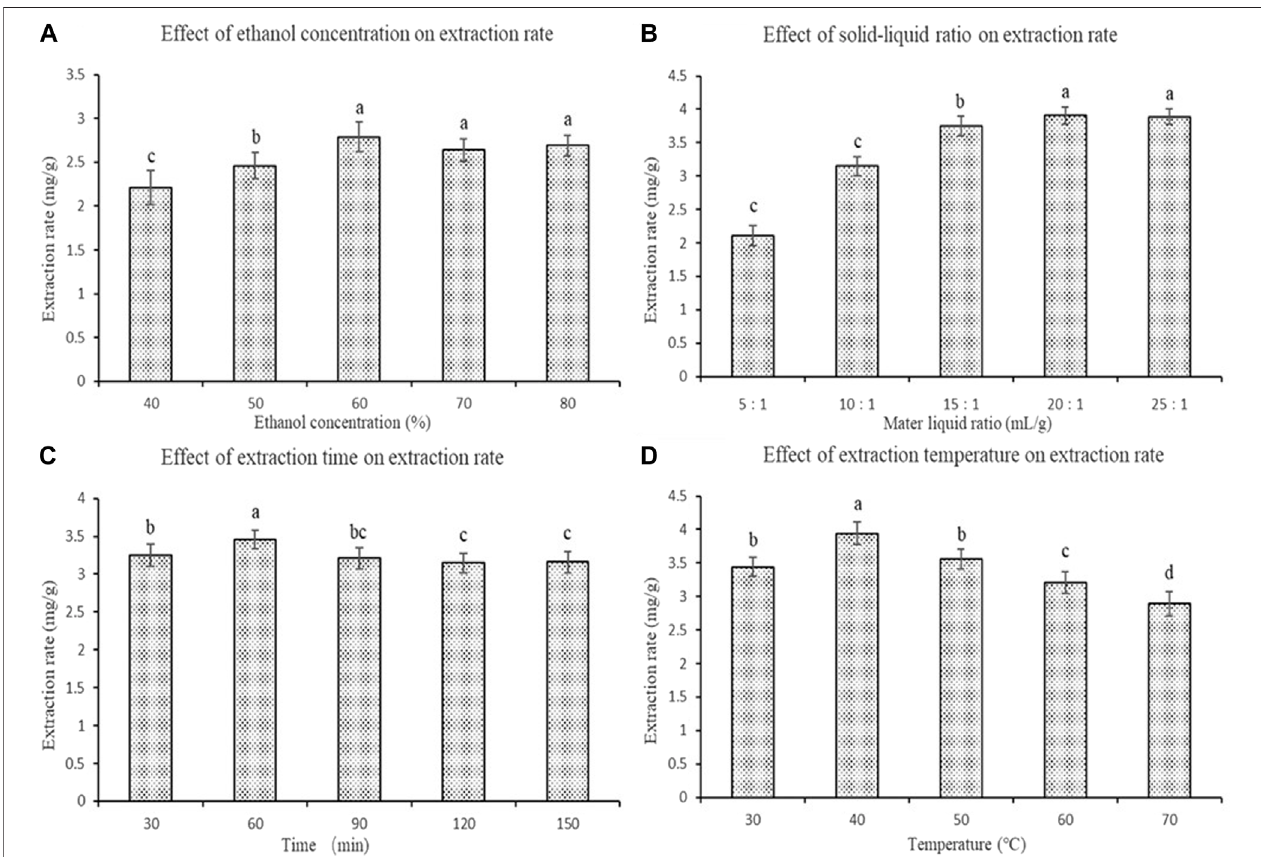
FIGURE1| Effectsoffoursinglefactors ontheextractionrateofpolyphenolsfromsweetsorghum (A) istheethanolconcentration (B) isthematerialliquid ratio (C) is the extraction time and (D) is the extraction temperature. The data are expressed as the mean ± standard deviation. One-way ANOVA ( p < 0.001) and Dunnett ’ s posttest were used for statistical analysis. Different lowercase letters in the fi gure indicate differences in signi fi cance.